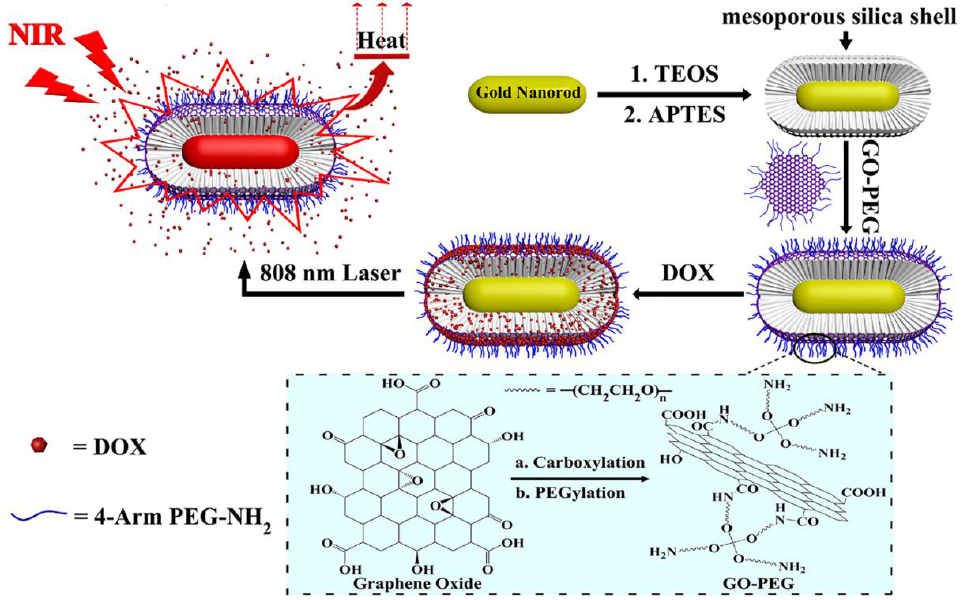
Figure 4. Preparation of GNRs/SiO 2 /GO-PEG nanoparticles. Reproduced from [36] with permission, copyright 2019, Elsevier.